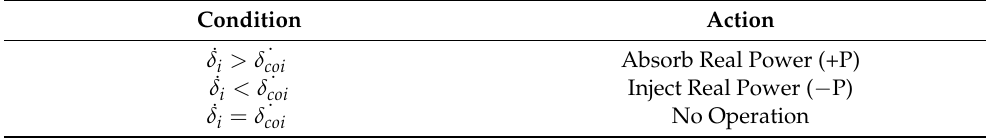
Table 3. Summary of controller’s